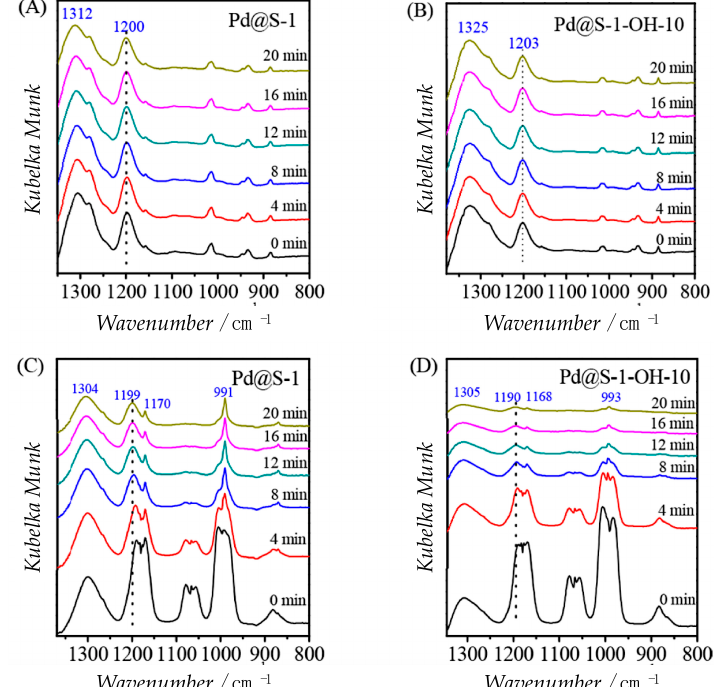
Figure 11. In situ FTIR spectra of ( A,B ) furfural and ( C,D ) furan on the Pd@S-1 and Pd@S-1-OH-10 catalysts during the desorption test. Adapted from ACS Catal. 2018, 8, 474–481, Reference